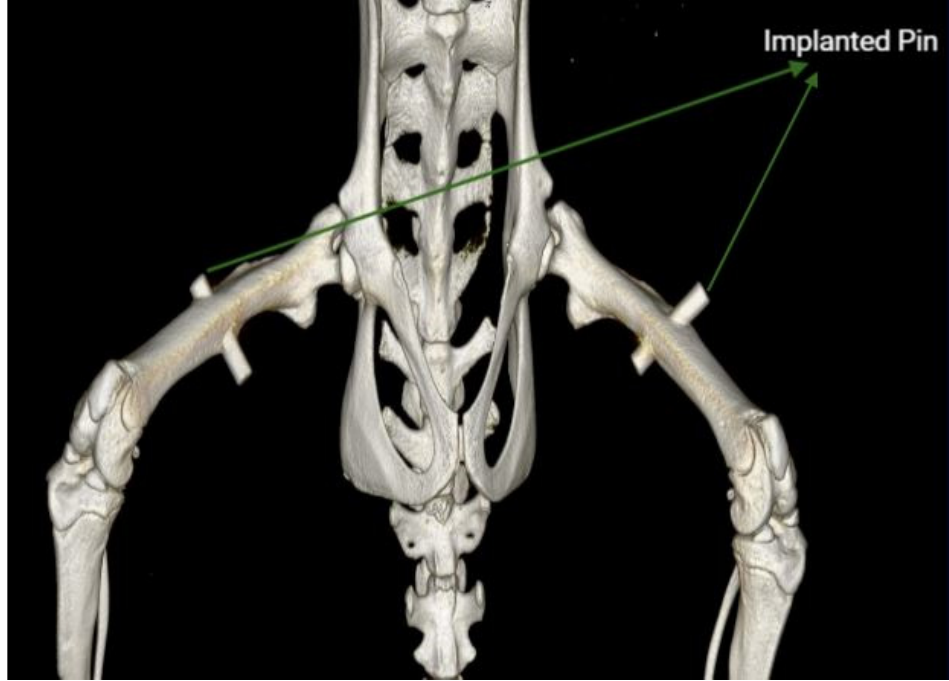
Figure 1. CT image showing the Mg implant positioning on day 7. Acquired with an IRIS PET/CT scanner (Inviscan Imaging System, Strasbourg, France), visualized in an OsiriX DICOM Viewer (Pixmeo, Switzerland).